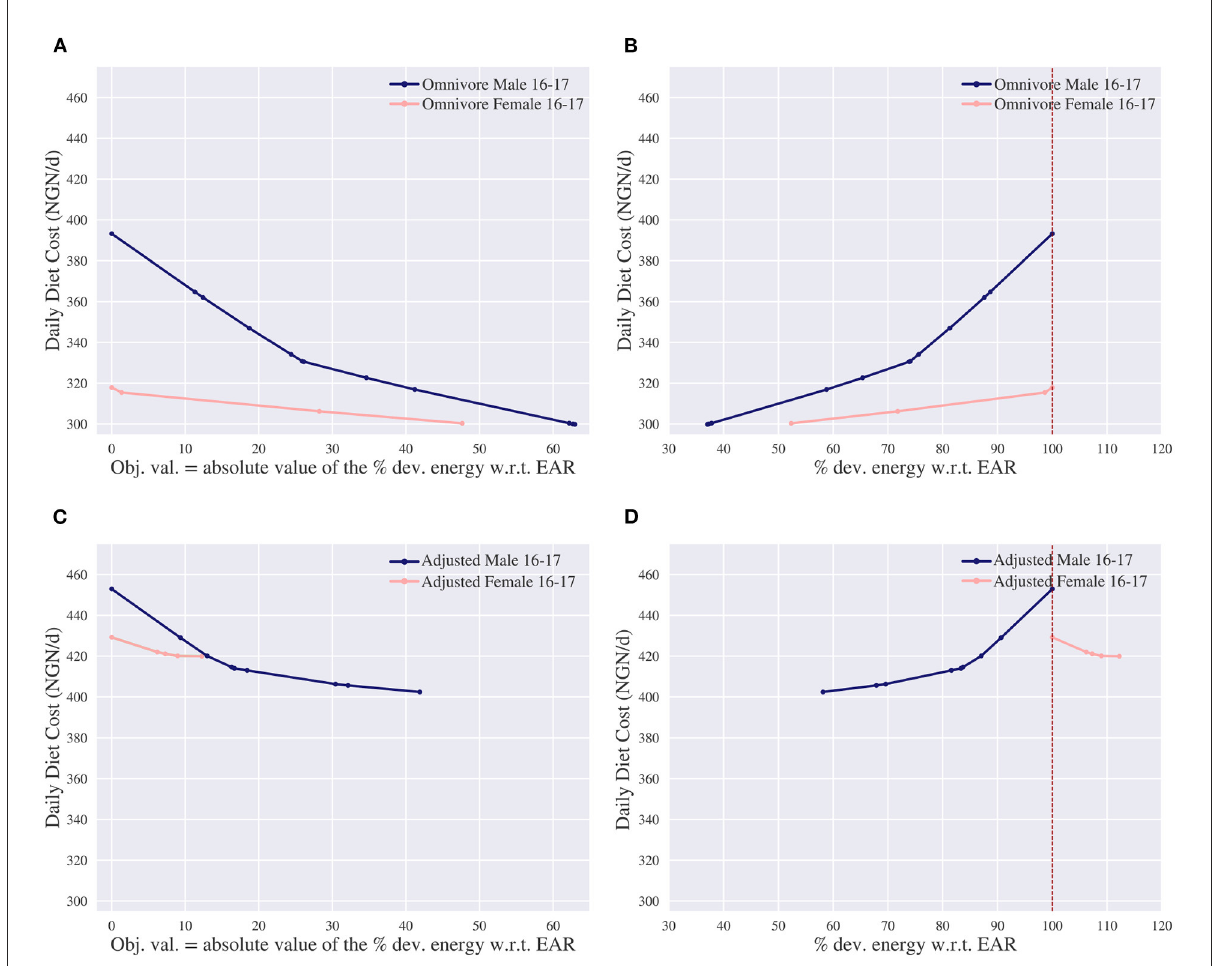
FIGURE7 Trade-offs of the daily diet cost in Nigerian naira (NGN) vs. energy deviation (dev.) for the omnivore and adjusted omnivore diet. The adjusted omnivore considers the same food commodities as omnivore, but excludes “Lamb, liver, raw,” “Leaf, amaranth, raw” and “Sesame, seeds, whole, dried, raw.” EAR denotes the estimated average requirement. (A) Pareto curve for the omnivore diet of the daily diet cost vs. absolute value of the deviation of energy w.r.t. EAR. (B) Energy deviation w.r.t. EAR of the omnivore diet. This is different from (A) , as (A) shows the model’s objective value which is the absolute value of the deviation in (B) . (C) Pareto curve for the adjusted omnivore diet of the daily diet cost vs. absolute value of the deviation of energy w.r.t. EAR. (D) Energy deviation w.r.t. EAR of the adjusted omnivore. This is different from (C) , as (C) shows the model’s objective value which is the absolute value of the deviation in (D)